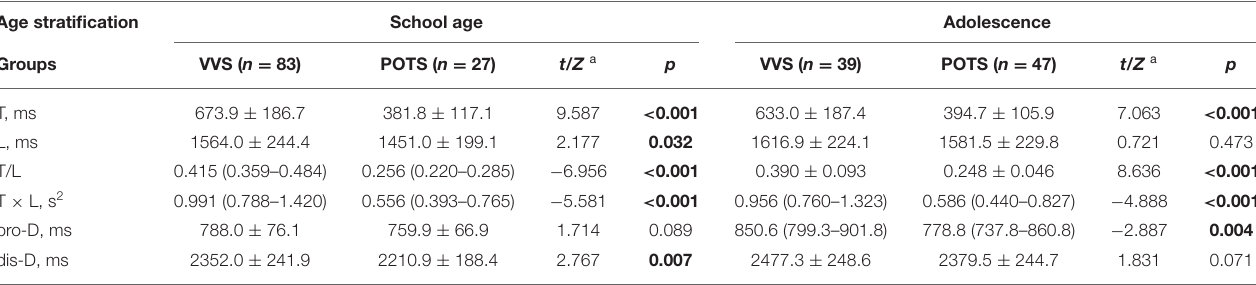
TABLE 3 | Comparison of graphic parameters of Poincaré plot between VVS and POTS groups in derivation study. Age